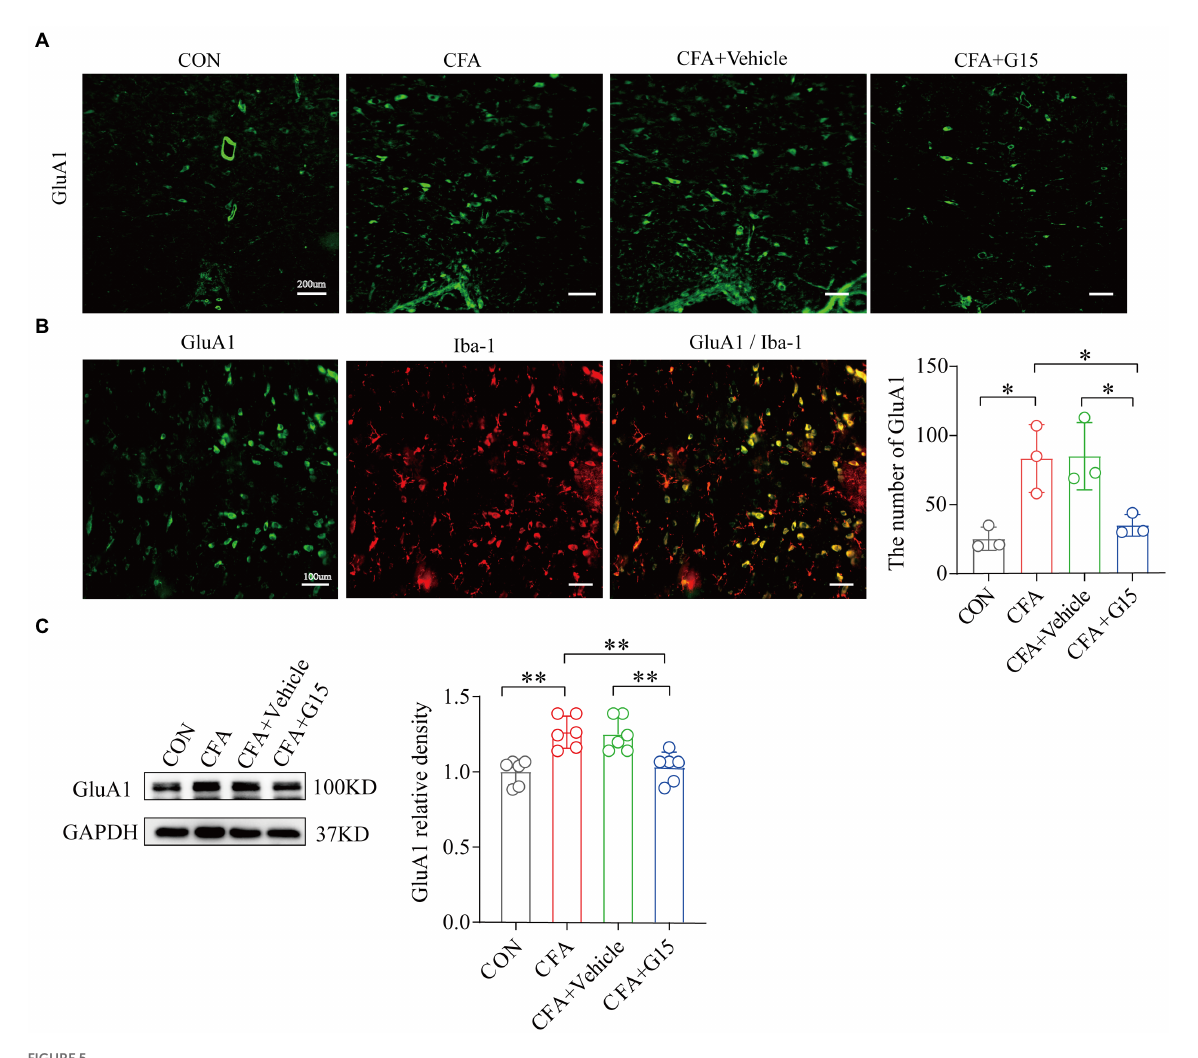
FIGURE 5 Expression of GluA1 and GluA1 co-localization in microglia. (A) Representative immunofluorescence images showing the distribution of Iba1 labeled microglia in the RVM of different pain states. (B) In CFA group, GluA1 was expressed in iba 1 labeled microglia. (C) Number of GluA1 in the RVM of rats in different states. The number of GluA1 was significantly reduced in the CFA + G15 group compared with the CFA group, while there was no significant difference between the CFA group and CFA + Vehicle group ( n = 3 per group). WB detected the expression of GluA1 (D) in RVM after G15 injection, and the expression of GluA1 protein was decreased in the CFA + G15 group compared with the CFA group ( n = 6 per group). There was no significant difference between the CFA group and the CFA + Vehicle group. Data represent the mean ± SD. All data of WB were normalized to the GAPDH control group. Statistical analysis was performed using one-way ANOVA followed by the Tukey post hoc test for multiple group comparisons. * p < 0.05, ** p <